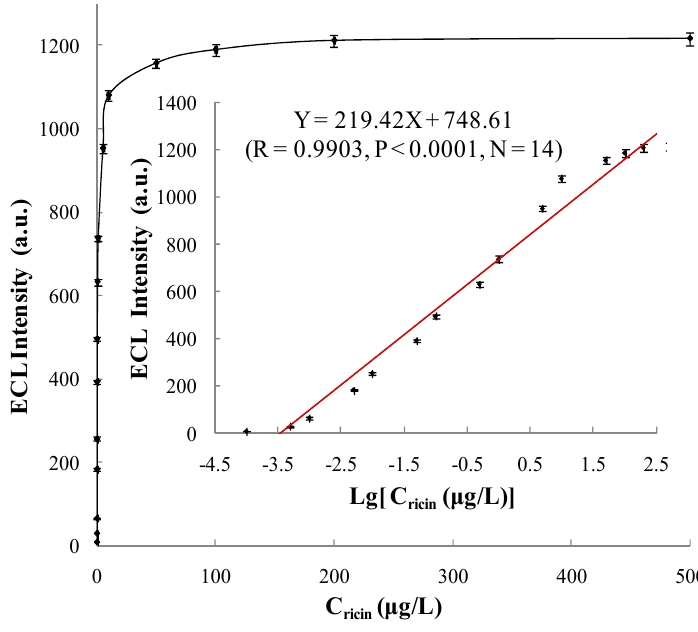
Figure 13. Standard curve of ricin determined by ECL immunosensor.